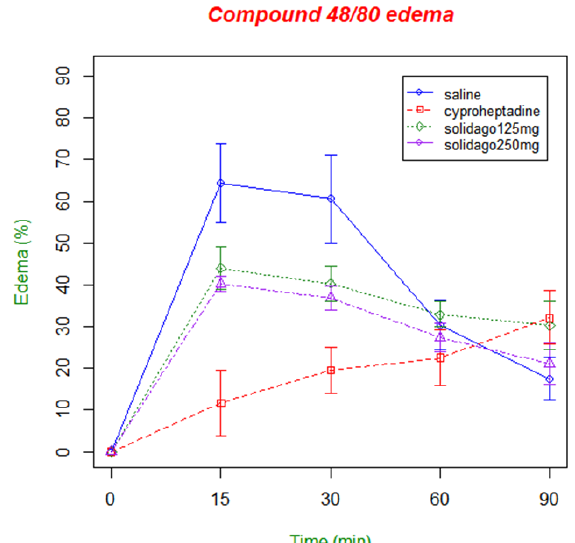
Figure 9. Variation in paw thickness percent 15 to 90 min after compound 48/80 administration. Animals were pretreated with vehicle (saline solution + 1% tween 80, 10 ml/kg), cyproheptadine 4 mg/kg, S. microglossa 125 mg/kg or S. microglossa 250 mg/ kg 30 min before intraplantar injection of compound 48/80 (50 μg/paw). Edema was measured with a digital caliper at each time point marked. N=8 for all groups. Statistical analyses were performed between the treated groups and the group treated only with the vehicle at certain times (15 min, 30 min, 60 min, and 90 min). Analysis of variance (two-way ANOVA) followed by Tukey’s multiple comparison of the means at the 95% familywise confidence